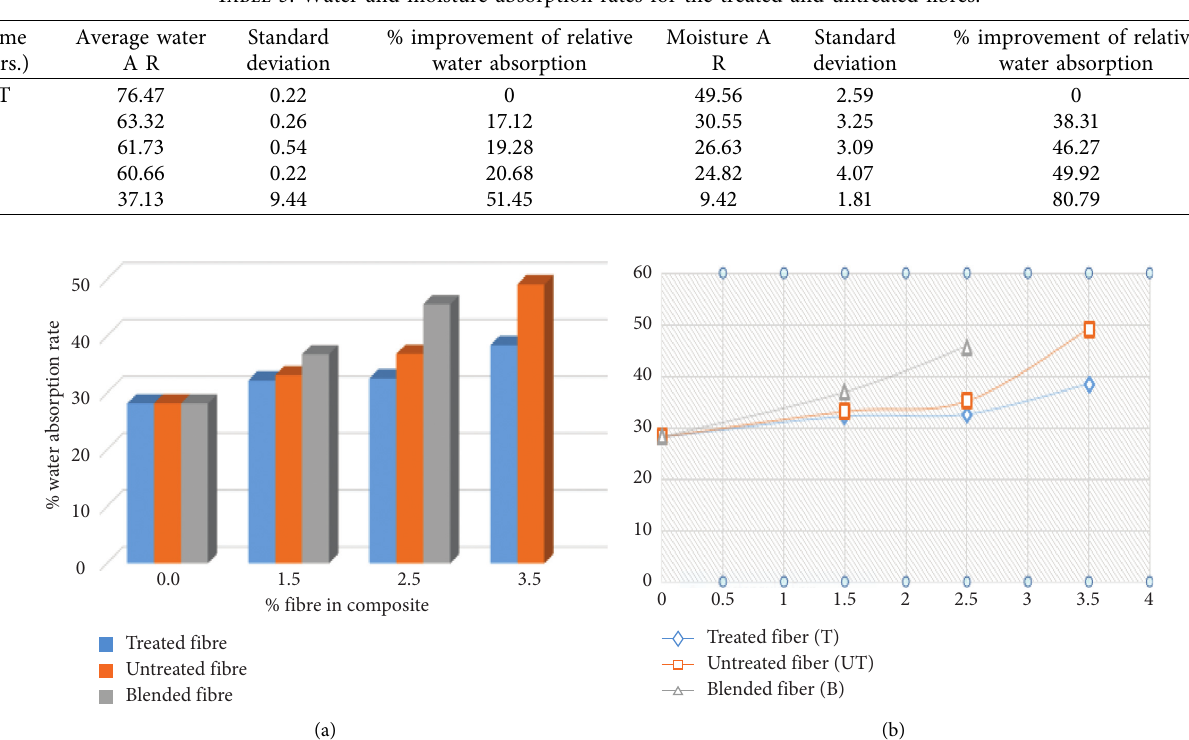
Figure 3: Water absorption rate of the reinforced hybrid fibre/gypsum plaster composite at different wt. % fibre dosages.